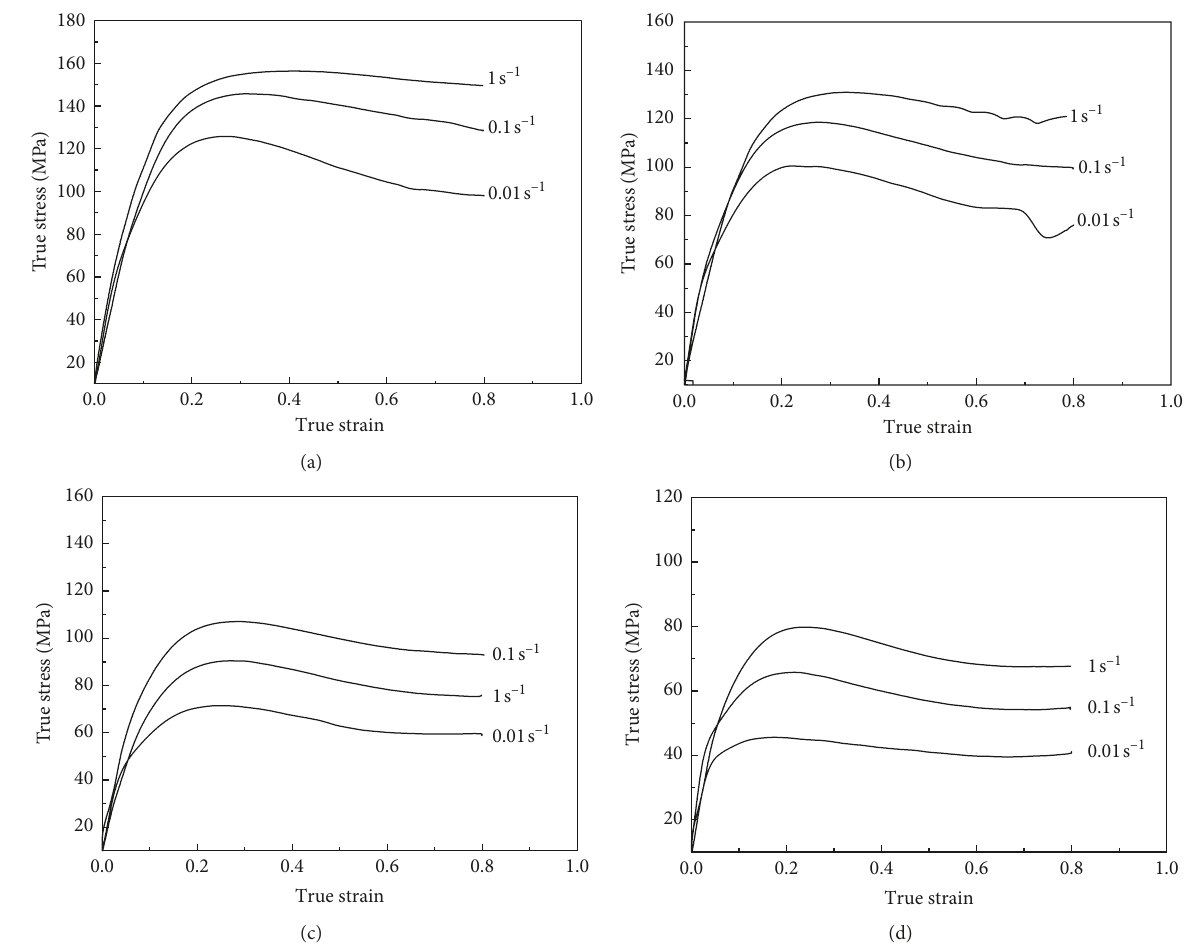
Figure 1: True stress-strain curves of AZ31 at varied temperatures: (a) 250 ° C; (b) 300 ° C; (c) 350 ° C; (d) 400 °